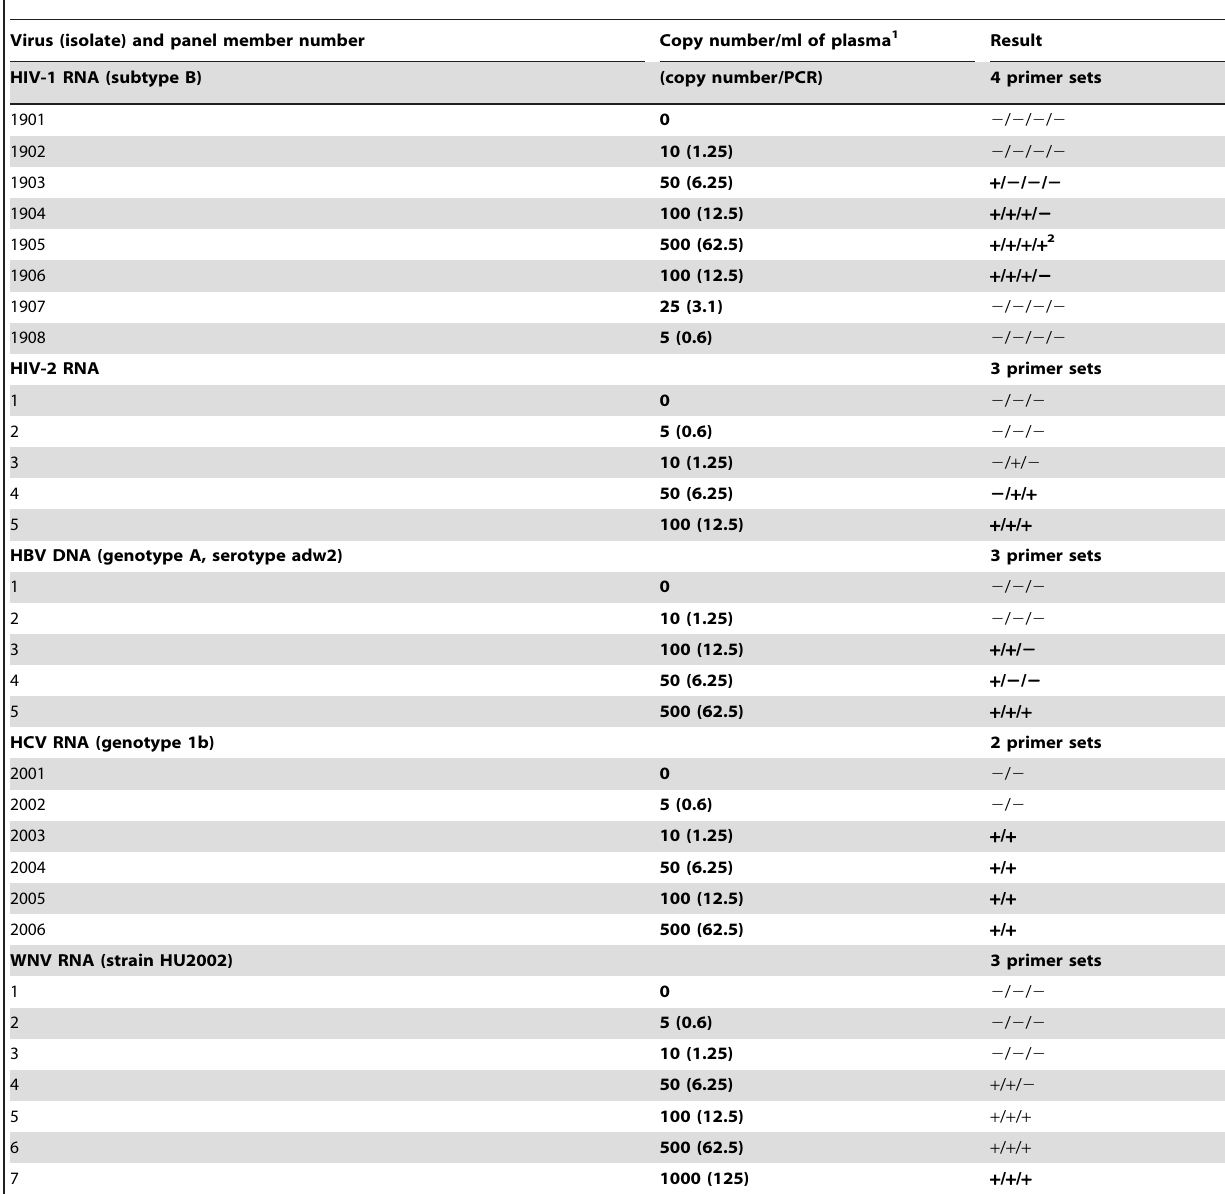
Table 2. The results of sensitivity testing of the real-time PCR array primer sets specific for HIV-1, HIV-2, HBV, HCV, and WNV the with FDA/CBER analytical plasma